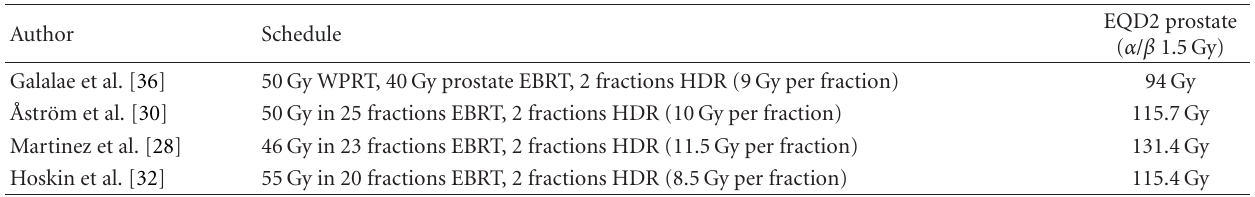
Table 2: Estimated equivalent doses (2Gy per fraction) for published HDR schedules using the EQD2 formula, assuming α / β for prostate cancer of 1.5 Gy